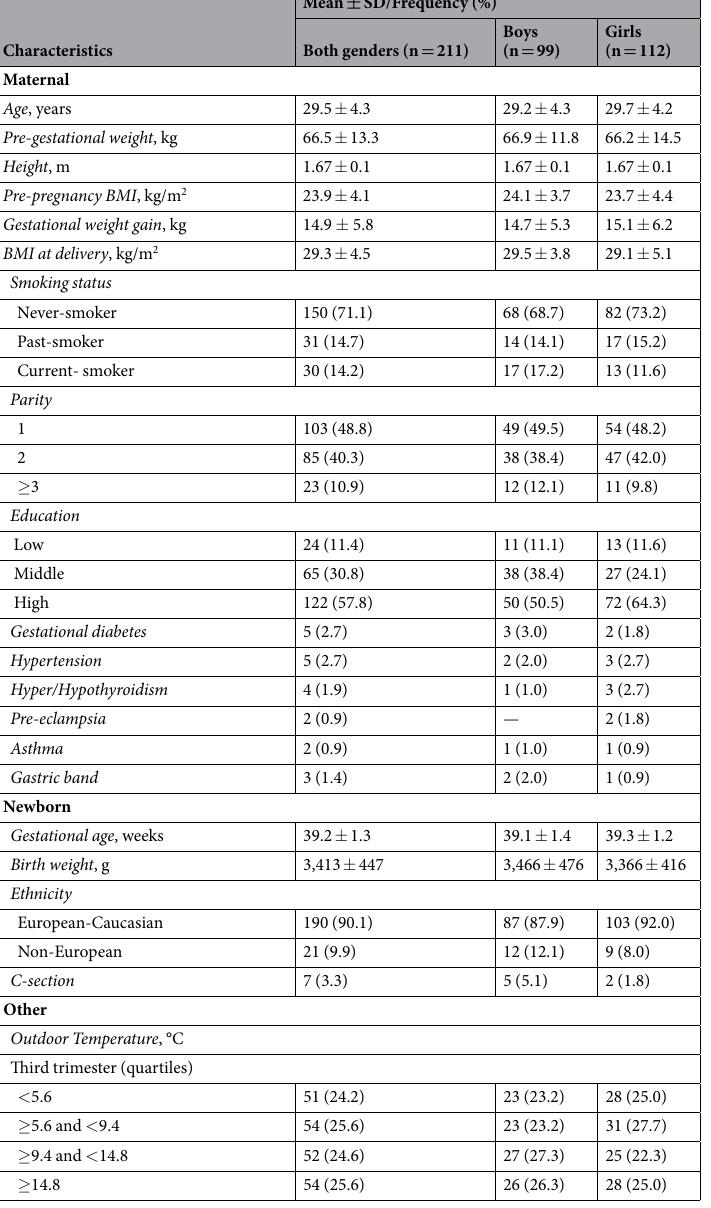
Table 2. Demographic characteristics of study population (n =